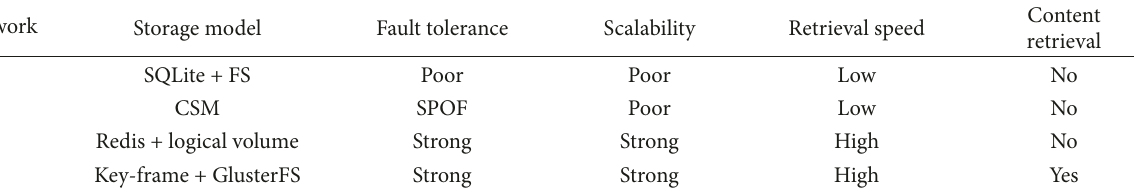
Table 1: System comparison.